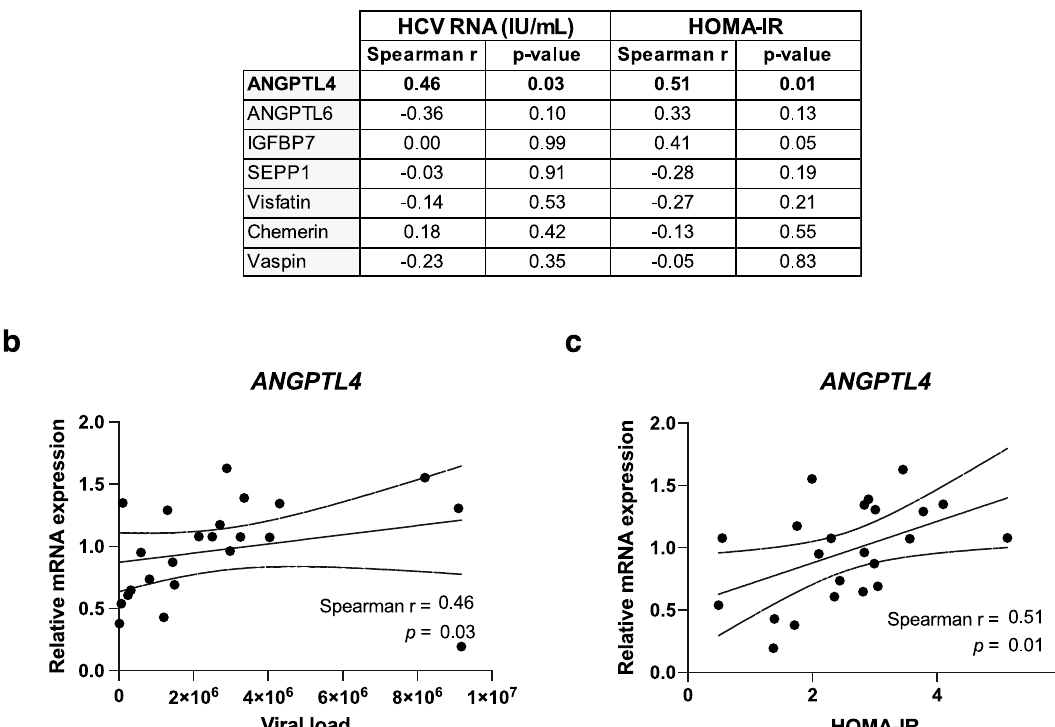
Figure 1. Hepatic mRNA expression of ANGPTL4 correlates with viral load and insulin resistance in CHC patients. ( a ) Correlation analysis between mRNA expression levels of ANGPTL-4 and -6, IGFBP7, SEPP1, visfatin, chemerin and vaspin with HCV RNA (IU/mL) and HOMA-IR in lean CHC patients ( n = 23); ( b-c ) correlation between liver ANGPTL4 mRNA expression and HCV RNA (B) and HOMA-IR ( c